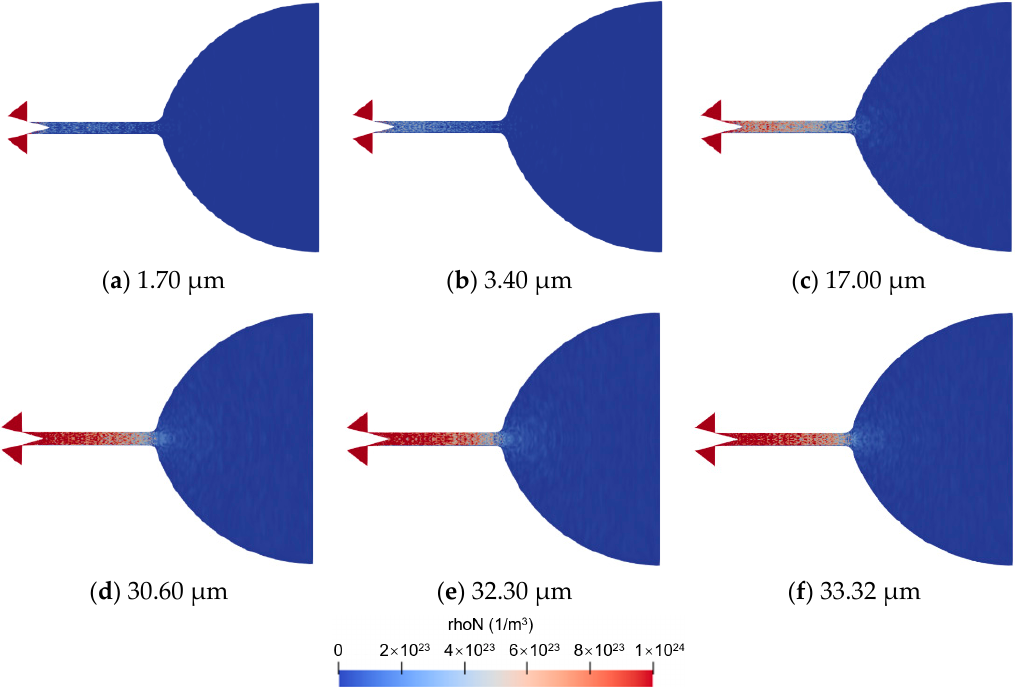
Figure 8. Molecular number density fields in the axial plane with different needle displacements at t = 0.1 ms .